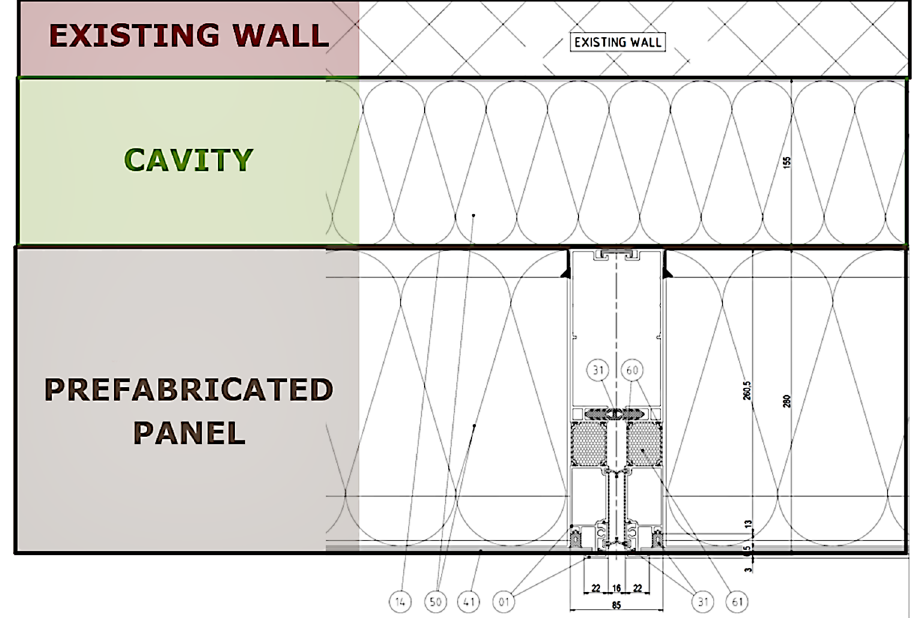
Figure 7. Envelope system’s wall composition.